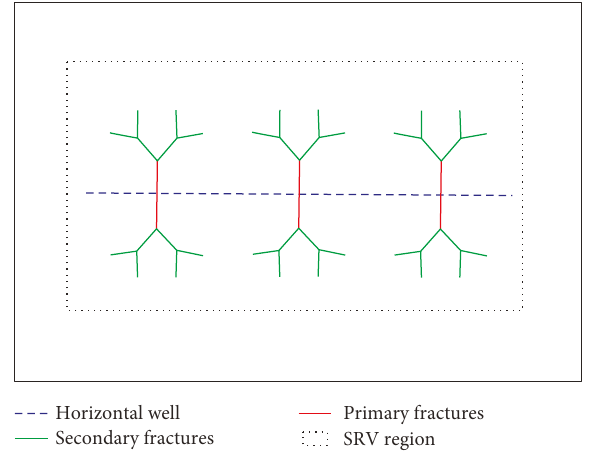
Figure 1: Schematic diagram of fracture networks in shale reservoir after hydraulic